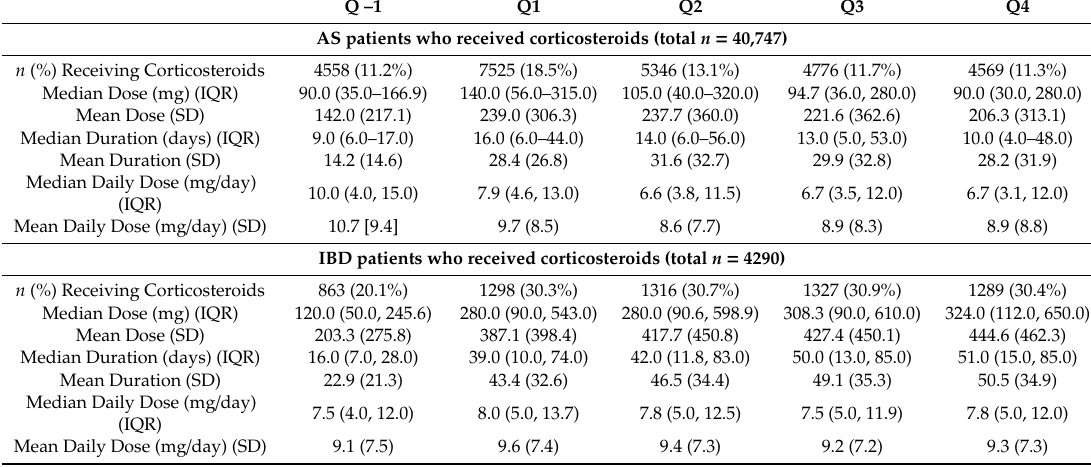
Table 2. Corticosteroid usage among patients with ankylosing spondylitis (AS) and inflammatory bowel disease (IBD) during the study period, by calendar quarter.